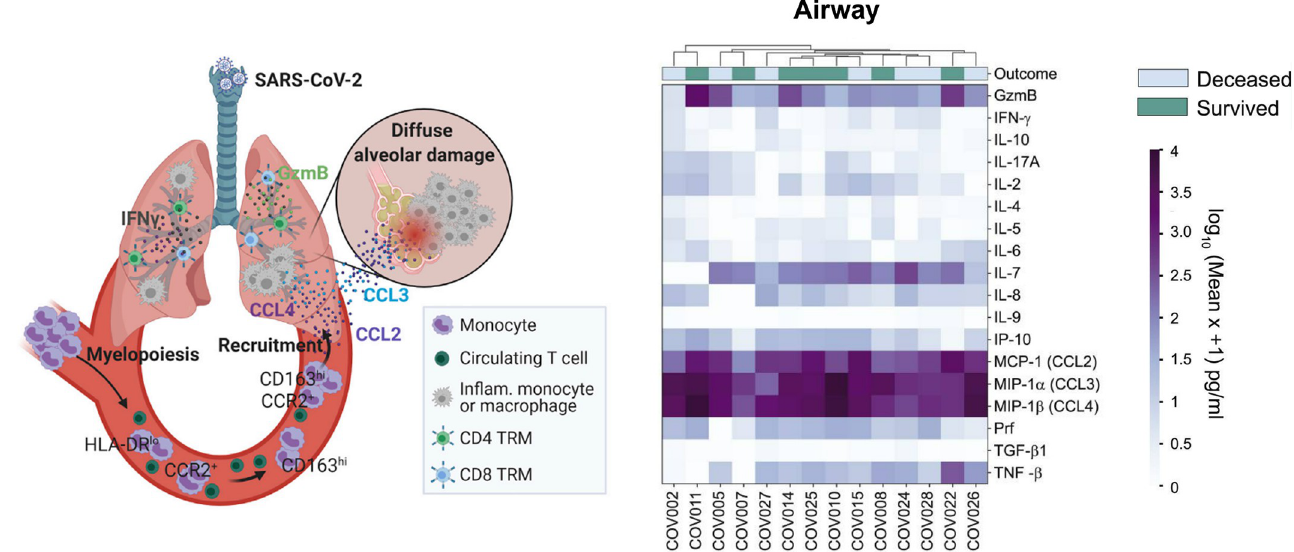
Fig 1. CCR2 mediated recruitment of aberrant myeloid compartment and high CCR2 and CCR5 ligands. Left: Diagrammatic summary representation of CCR2- and CCR5-mediated recruitment of aberrant myeloid compartment via elevated airway CCR2 and CCR5 agonist ligand expression in airways of patients with severe COVID-19 infection. Right: Heatmap showing inflammatory mediators in airway samples from 14 COVID-19 patients ( x axis) highlighting specifically elevated CCR2 and CCR5 cognate ligands MCP-1 [CCL2], MIP-1 α [CCL3], and MIP-1 β [CCL4] levels (average elevation relative to uninfected controls graded in purple as per key). Reprinted from Immunity , 54 (4), Szabo PA, et al. Longitudinal profiling of respiratory and systemic immune responses reveals myeloid cell-driven lung inflammation in severe COVID-19. 797–814. Copyright (2021), with permission from Elsevier et al. CCL, chemokine- chemokine ligand; CCR, chemokine-chemokine receptor; COVID-19, Coronavirus Disease 2019; MCP, monocyte chemoattractant protein; MIP, monocyte inflammatory protein.